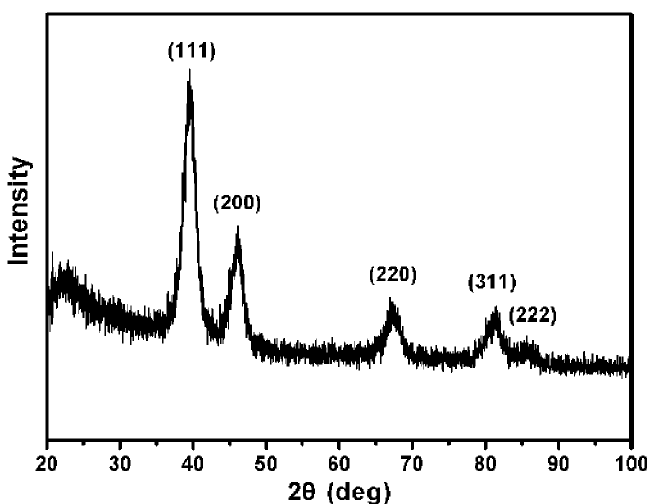
Figure 2. Powder X-Ray diffraction (XRD) pattern of ultrasmall Pt